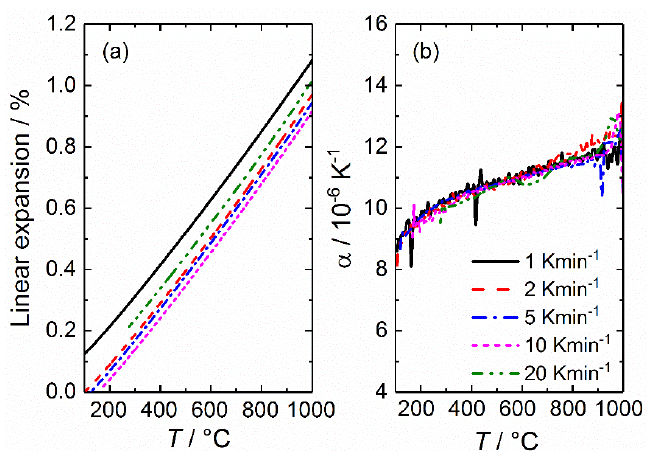
Figure 3. Linear expansion ( a ) and its corresponding first order derivative in ( b ), plotted as a function of temperature for YSZ for all cooling rates (1 – 20 K min − 1 ), dry Ar.